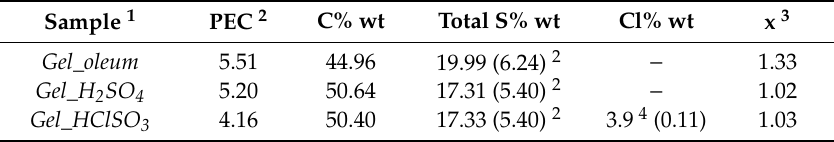
Table 1. Analytical data on the composition of the sulfonic